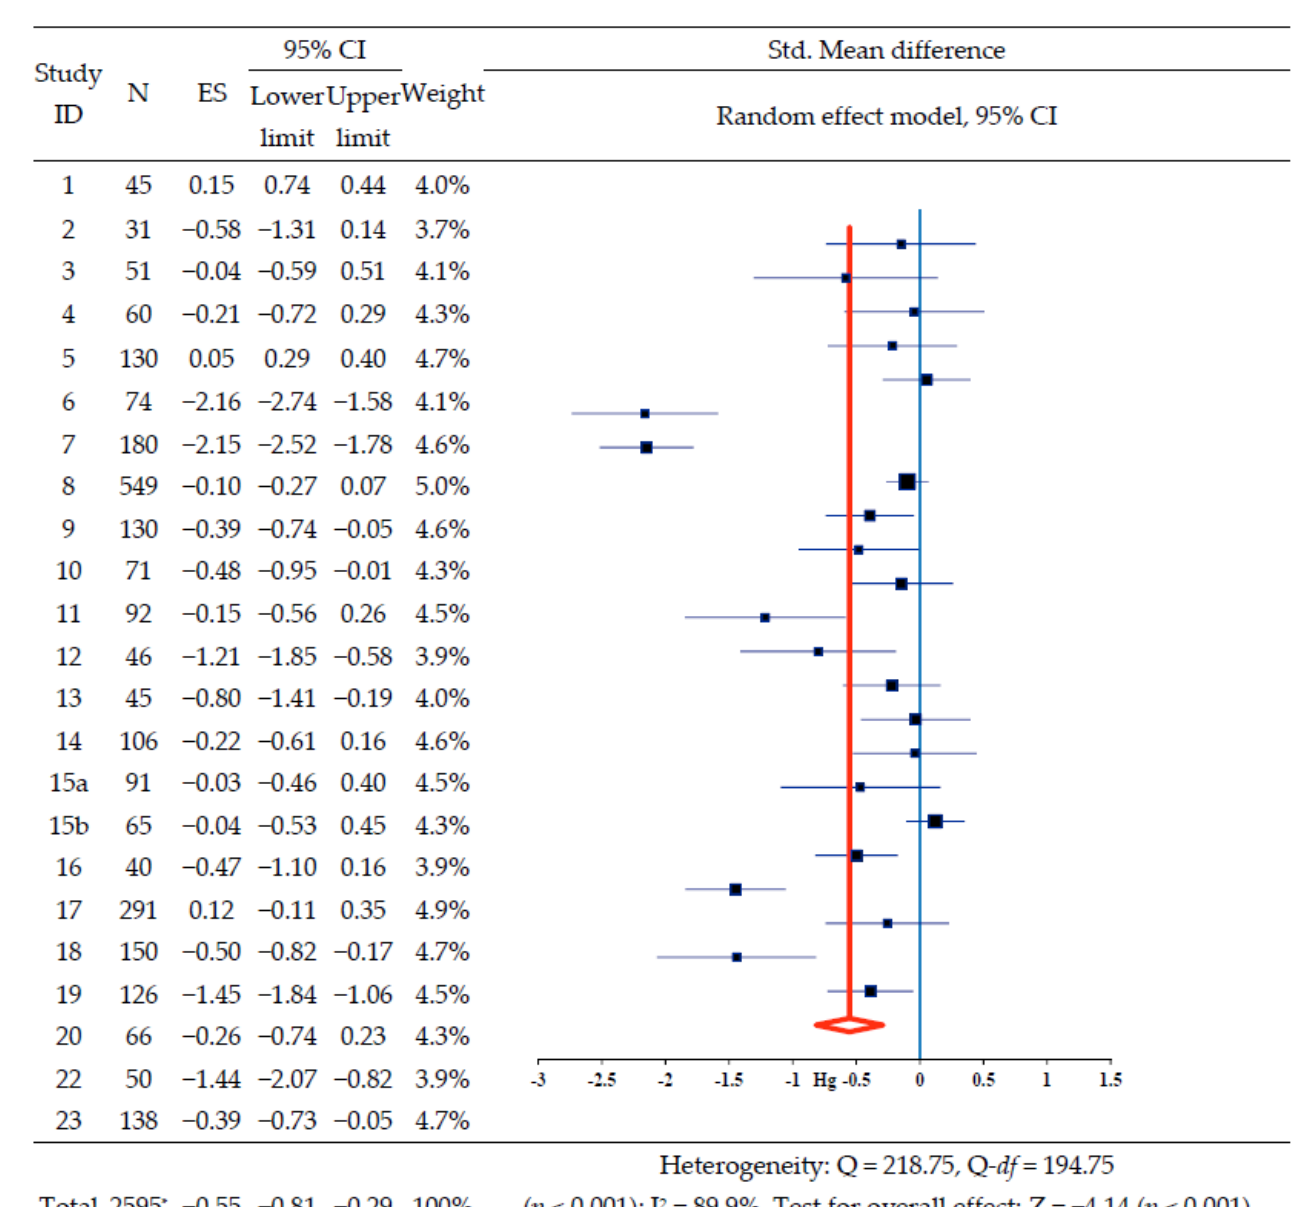
Figure 2. The effect of self-management nursing intervention on HbA1C. Notes. * Duplicate removal of the number of subjects Jutterstrom et al. (2016)’s study, HbA1C: glycosylated hemoglobin, ES: effect size, and CI: confidence interval.